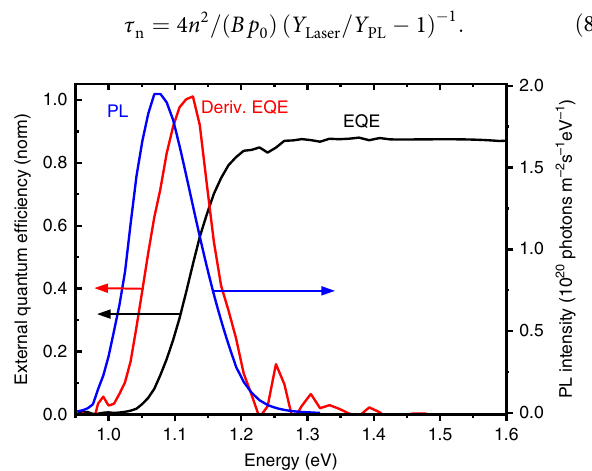
Fig. 6 External quantum ef fi ciency and photoluminescence. EQE spectrum (black) and the fi rst derivative of the EQE curve (red) of the high-ef fi cient solar cell as well as the average absolute PL spectrum (blue) acquired also on the identical solar cell at an excitation equivalent to the illumination intensity of one